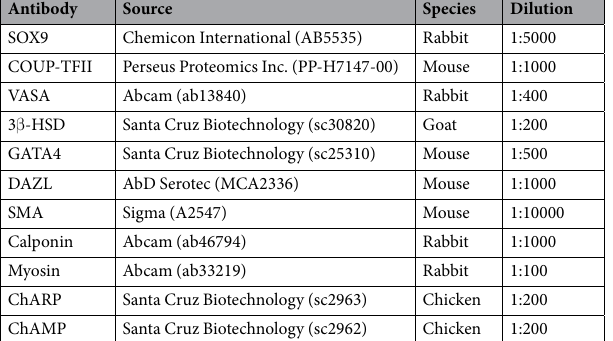
Table 1. Antibodies used for immunofluorescence. Abbreviations: SMA, smooth muscle actin; ChARP, chicken anti-rabbit peroxidase; ChAMP, chicken anti-mouse